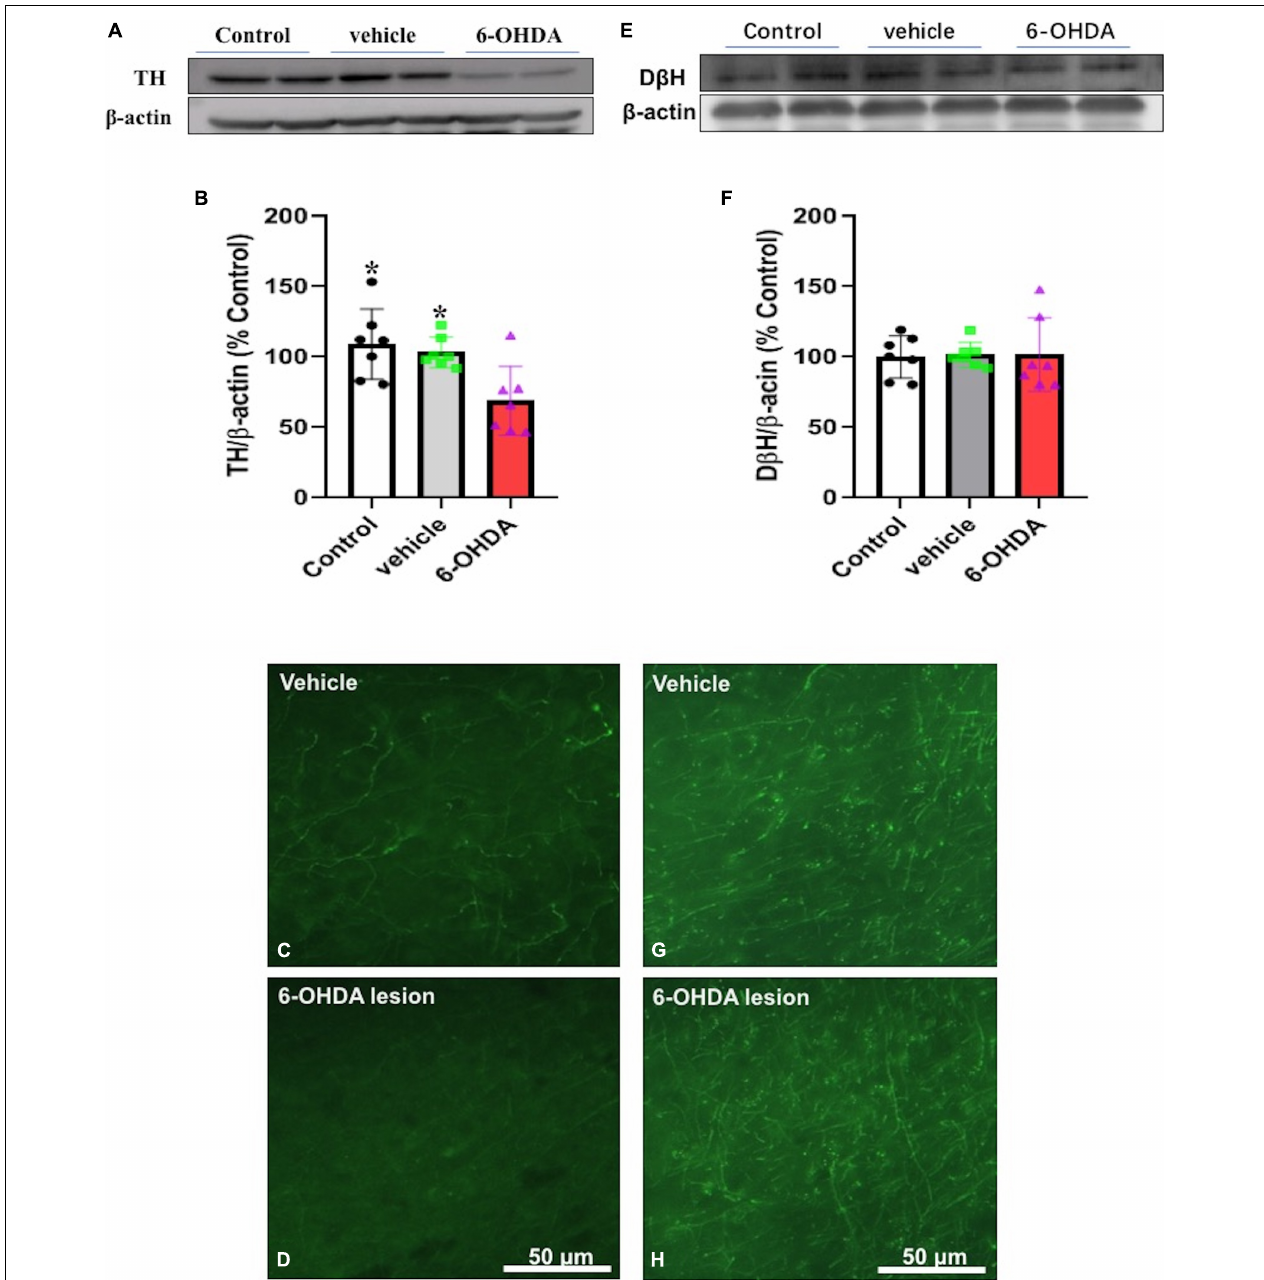
FIGURE 4 | Immunoblotting or immunofluorescence was performed on Day 7 after the microinjection and protein expression of tyrosine hydroxylase (A–D) and dopamine beta-hydroxylase (E–H) in the mPFC of the vehicle control (vehicle) and the 6-hydroxydopamine (6-OHDA) microinjected mice * p < 0.05, compared with the 6-OHDA group ( n = 7 per